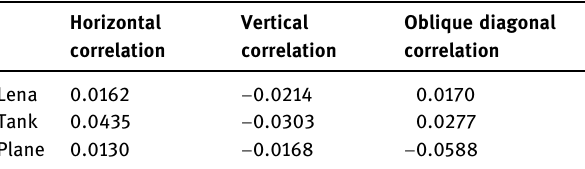
Table 2: Statistical experimental analysis table of image correlation